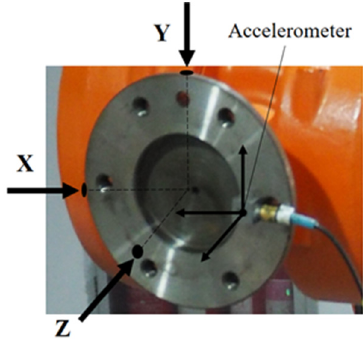
Figure 4. Directions of accelerometer and excitations.